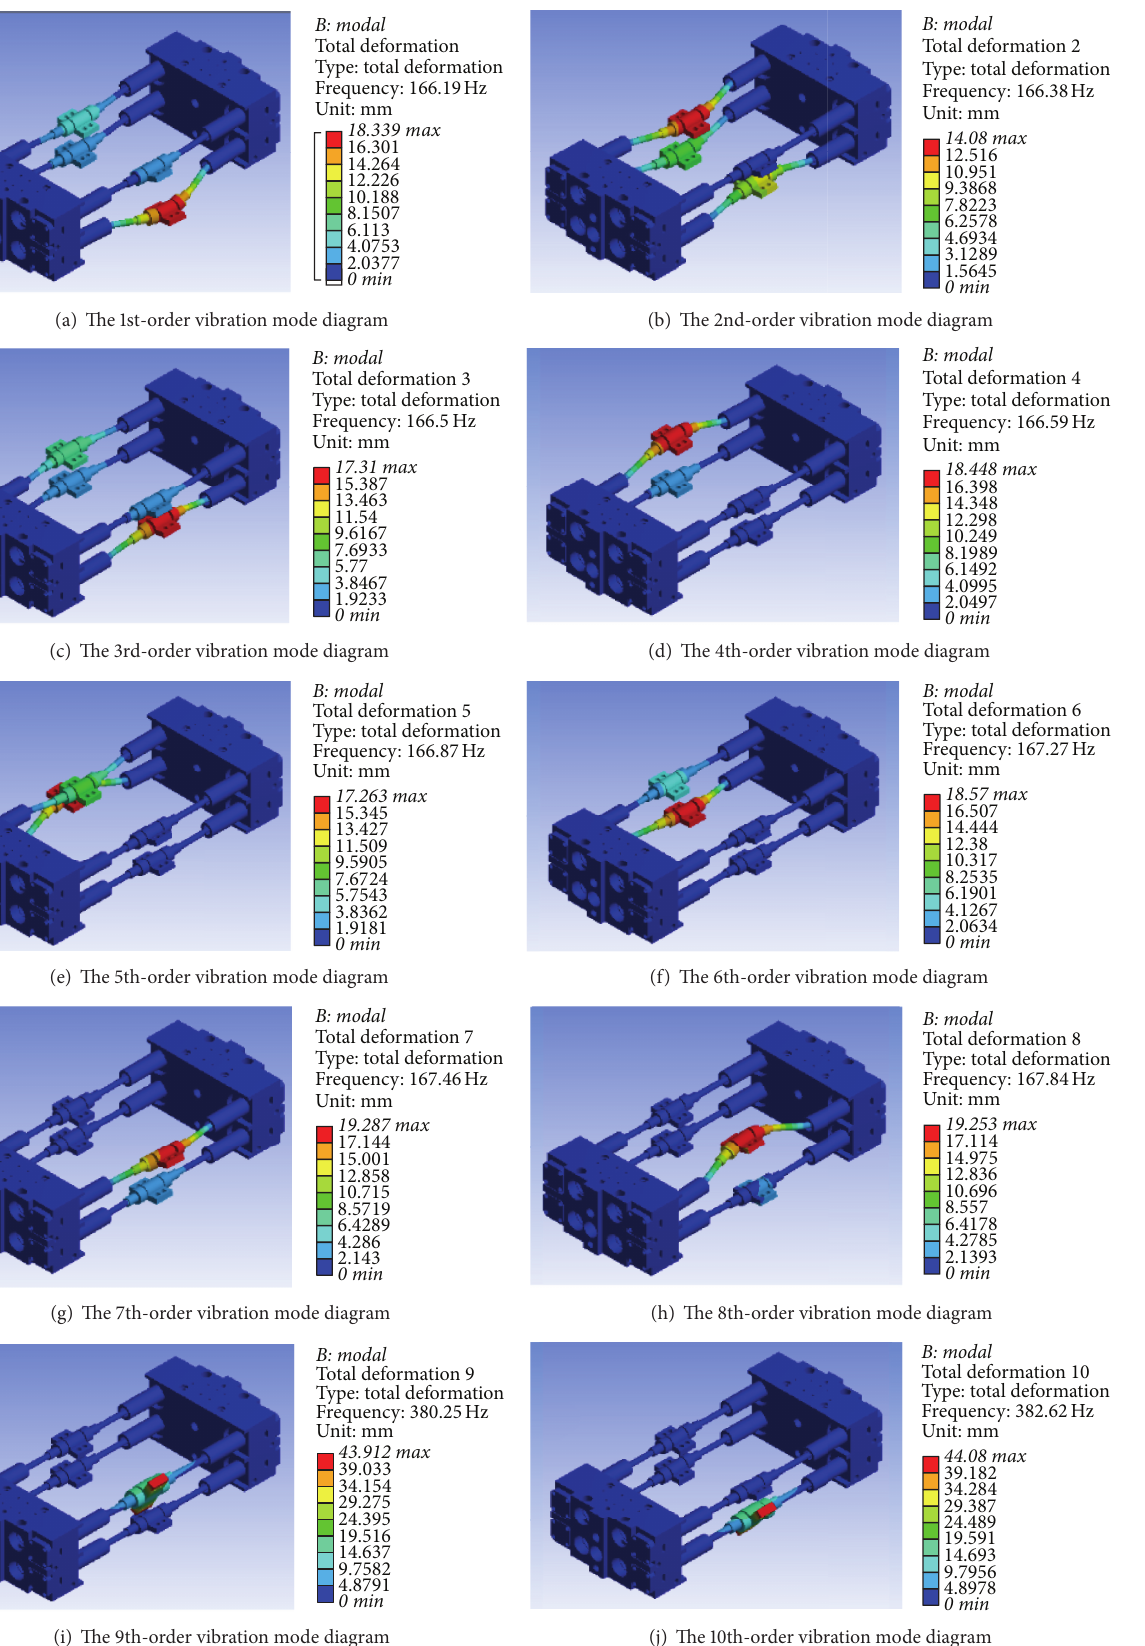
Figure 5: The fore ten-order mode shapes and natural